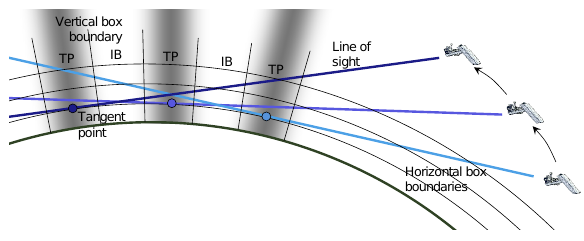
Fig. 3. Definition of the horizontal model space for the interpo- lation approach with respect to the tangent points of the scanning sequences if additional intermediate boxes are introduced. TP and dark shading indicates boxes around the tangent points, IB and white shading indicates the intermediate boxes. For illustration pur- poses, the LOS is shown for only one measurement per scanning sequence (at the same TH).